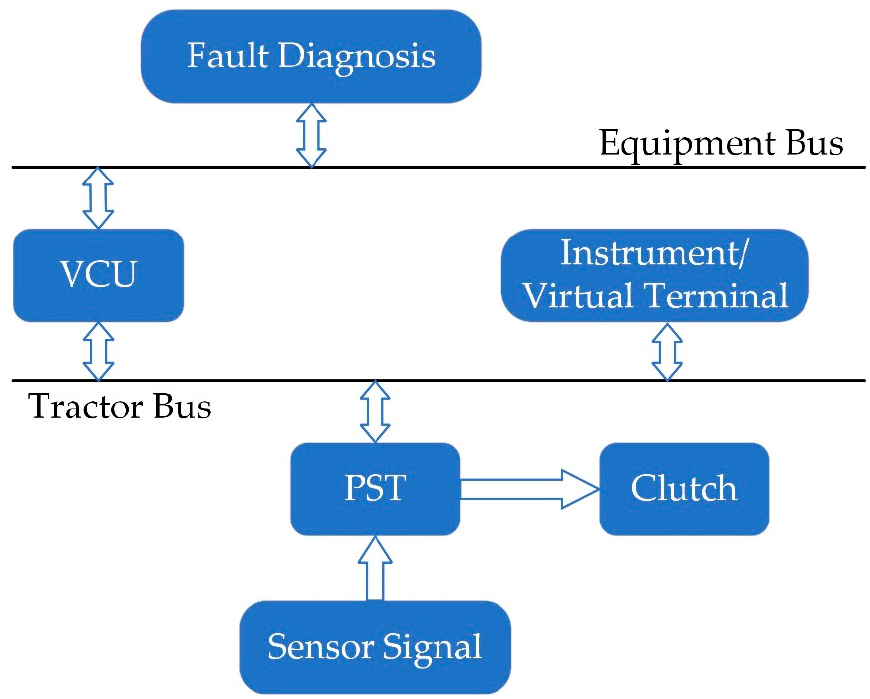
Figure 8. Block diagram of fault diagnosis of PST electro-hydraulic system based on CAN bus.